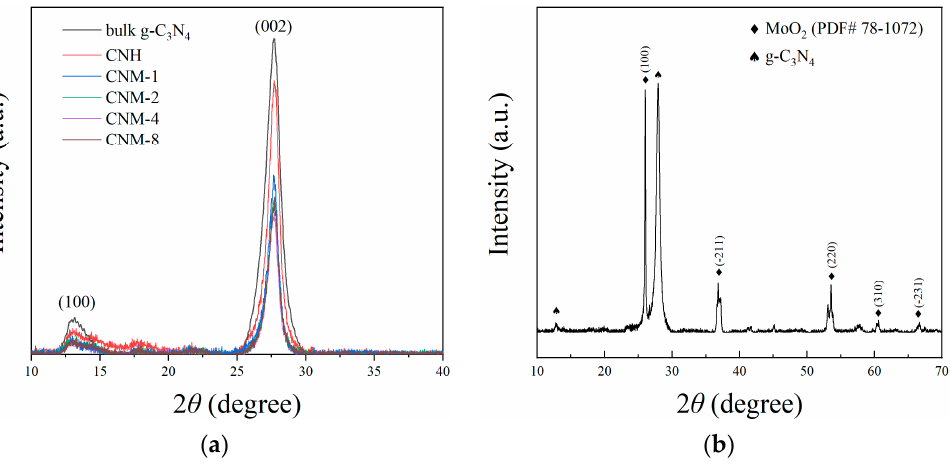
Figure 2. XRD results: ( a ) comparison on the patterns of CNM, CNH, and bulk g-C 3 N 4 , and ( b ) single pattern for the optimal sample CNM-4 thermally treated under air for another 3 h.